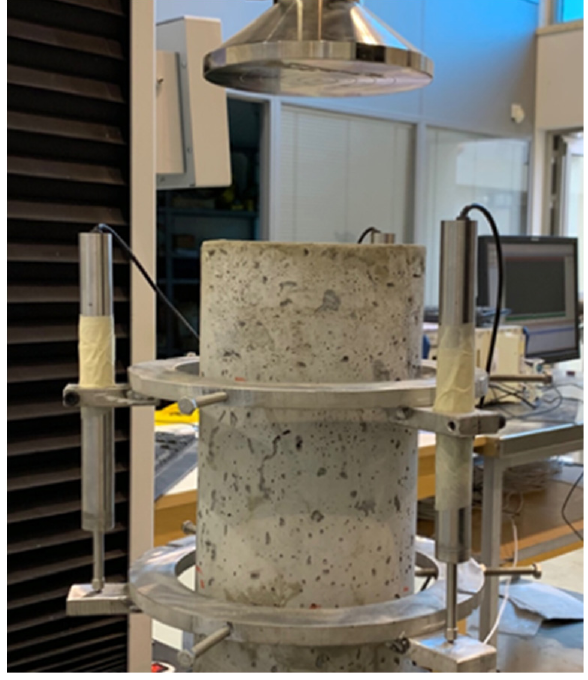
Figure 2. Cyclic compressive loading specimen setup.